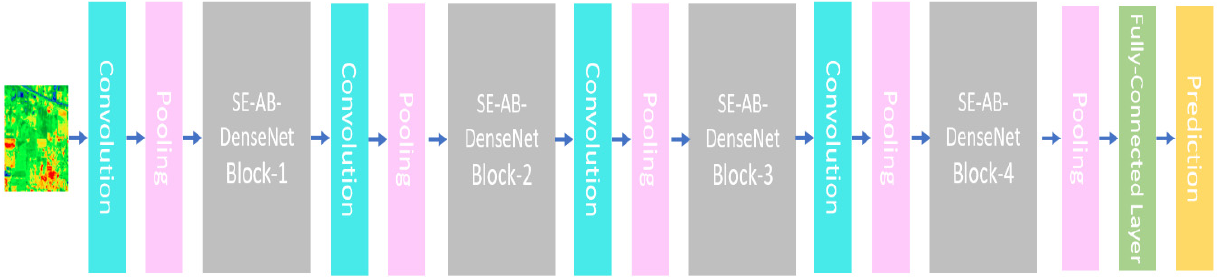
Figure 2. The basic structure of proposed SE-AB-DenseNet with cutout. Table 1. Structure details of SE-AB-DenseNet